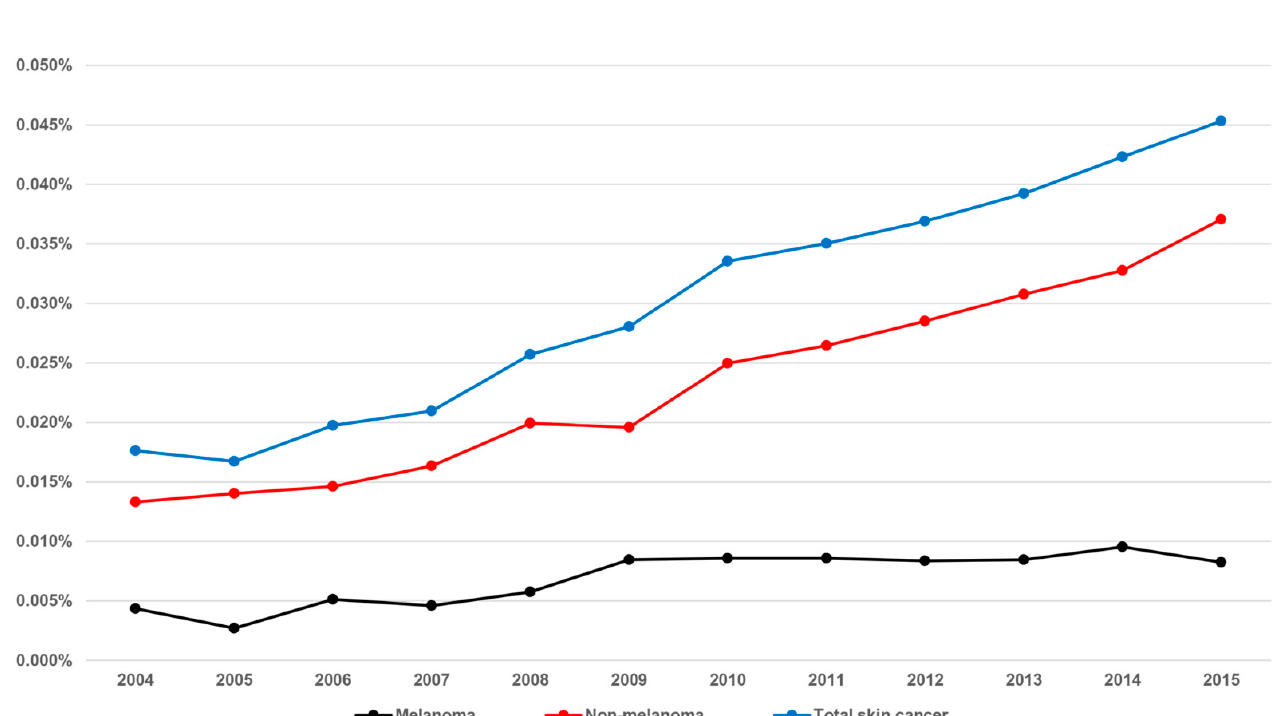
Figure 1. Prevalence of melanoma, non-melanoma skin cancer, and total skin cancer during the study period. Table 2. Demographic characteristics of the population included in the